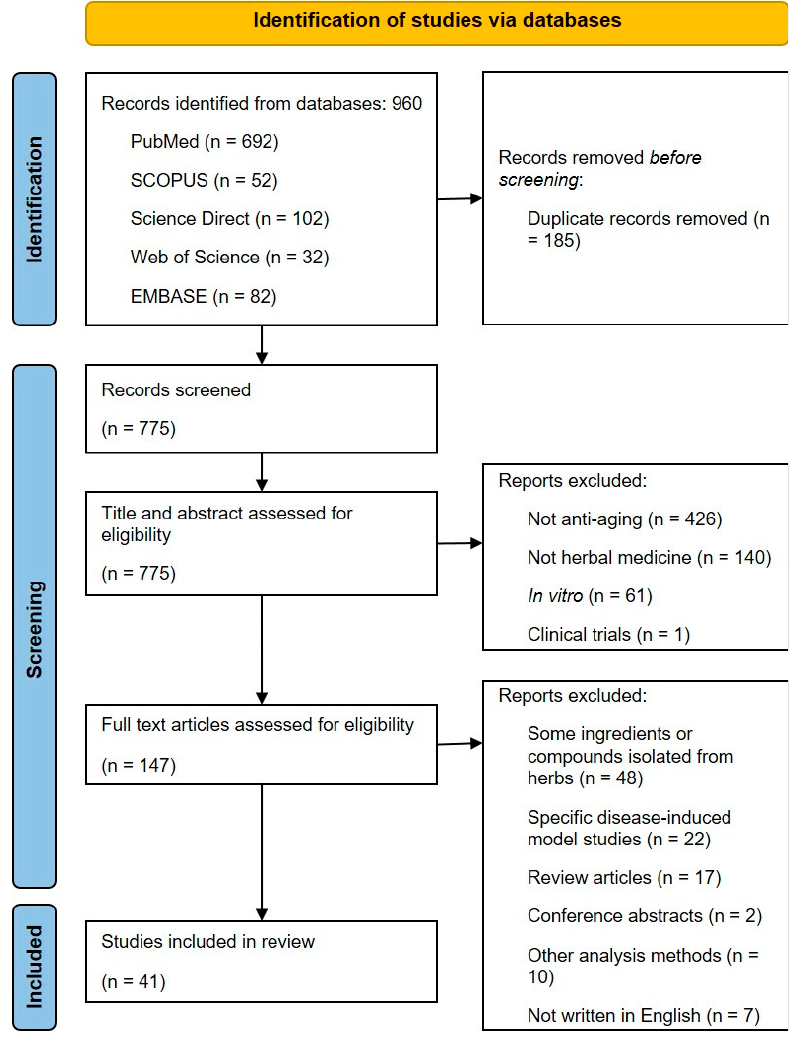
Figure 1. Flow diagram of the systematic review study selection process.